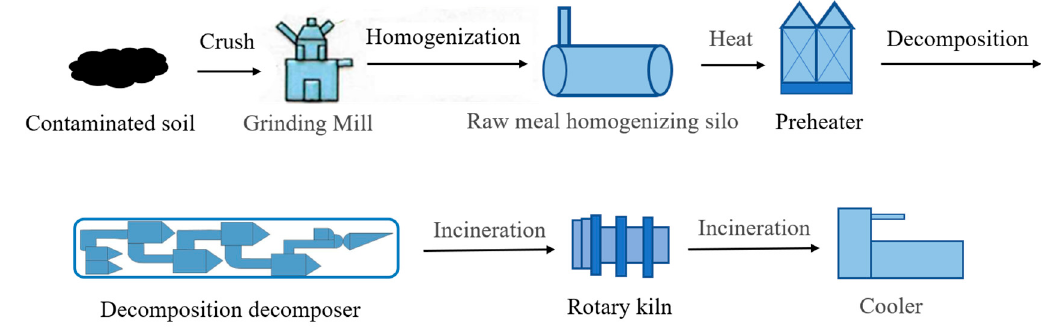
Figure 2. Co-processing in cement kiln for contaminated soil treatment.